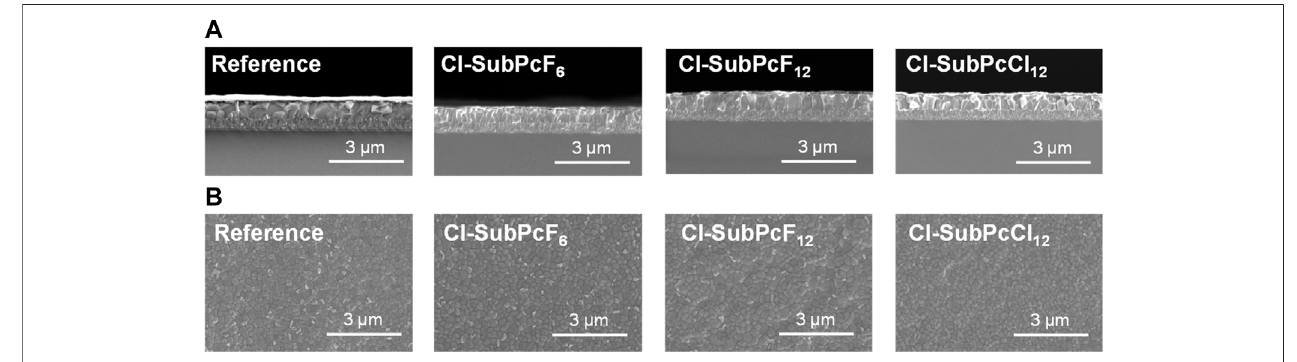
FIGURE 5 | (A) Cross-sectional and (B) top-view SEM images of the reference and SubPc-containing